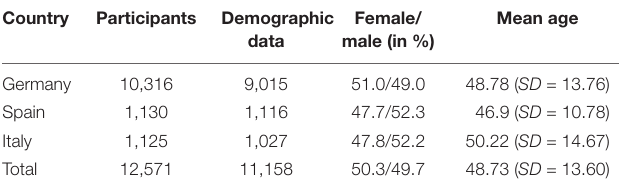
TABLE 2 | Overview of the participant sample. Country Participants Demographic